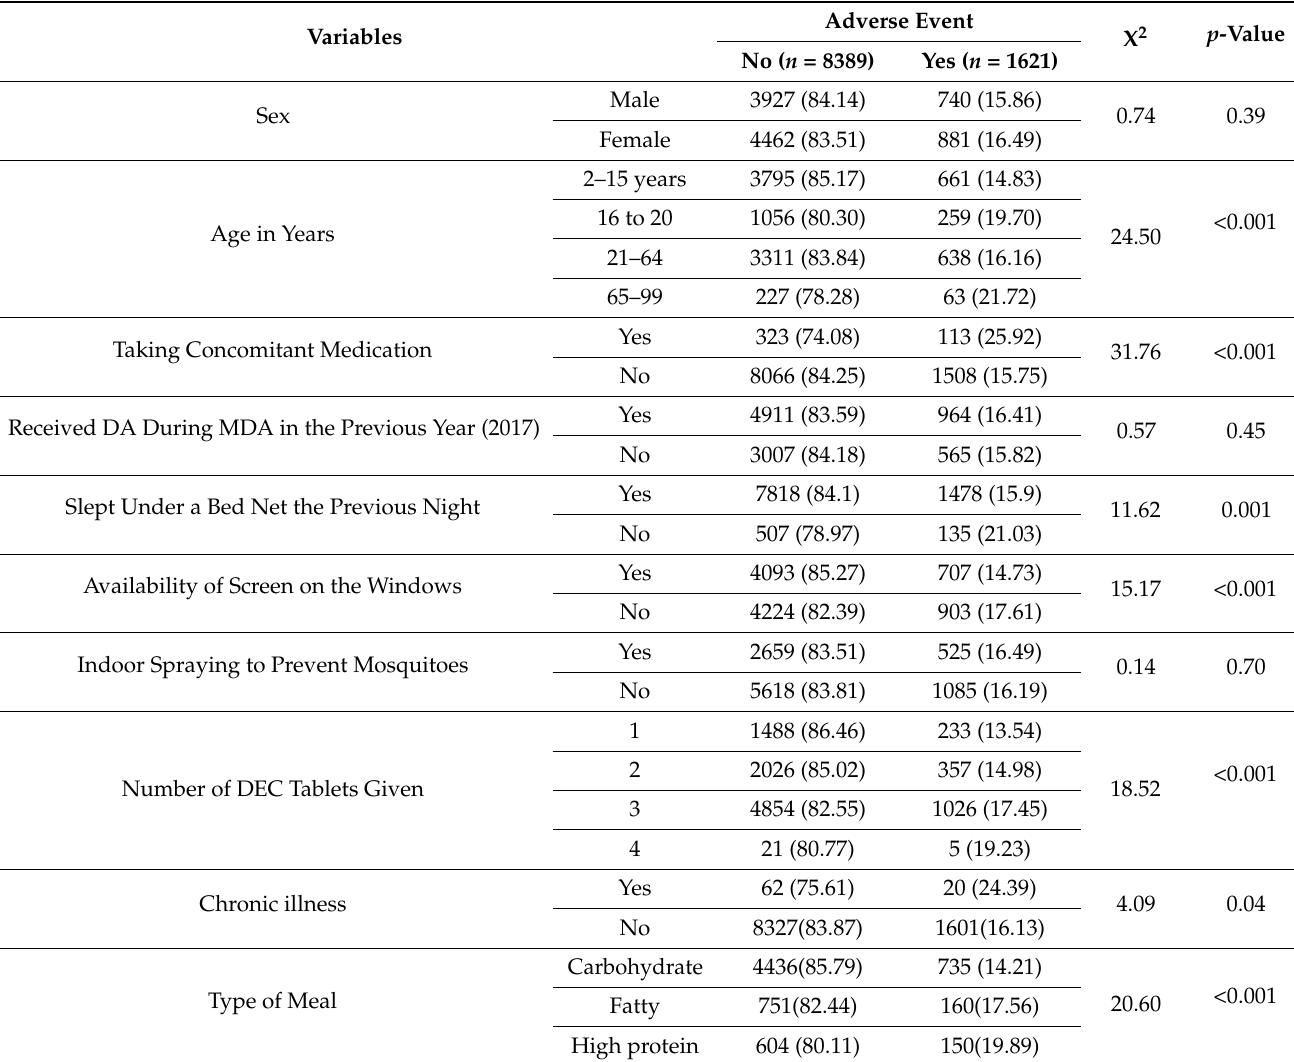
Table 3. Incidence and correlations of adverse events following mass diethylcarbamazine and albendazole administration for the elimination of lymphatic